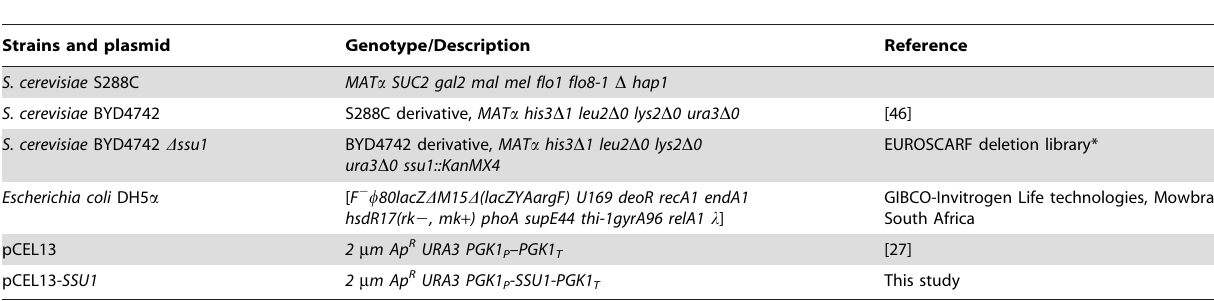
Table 1. Yeast strains used in this